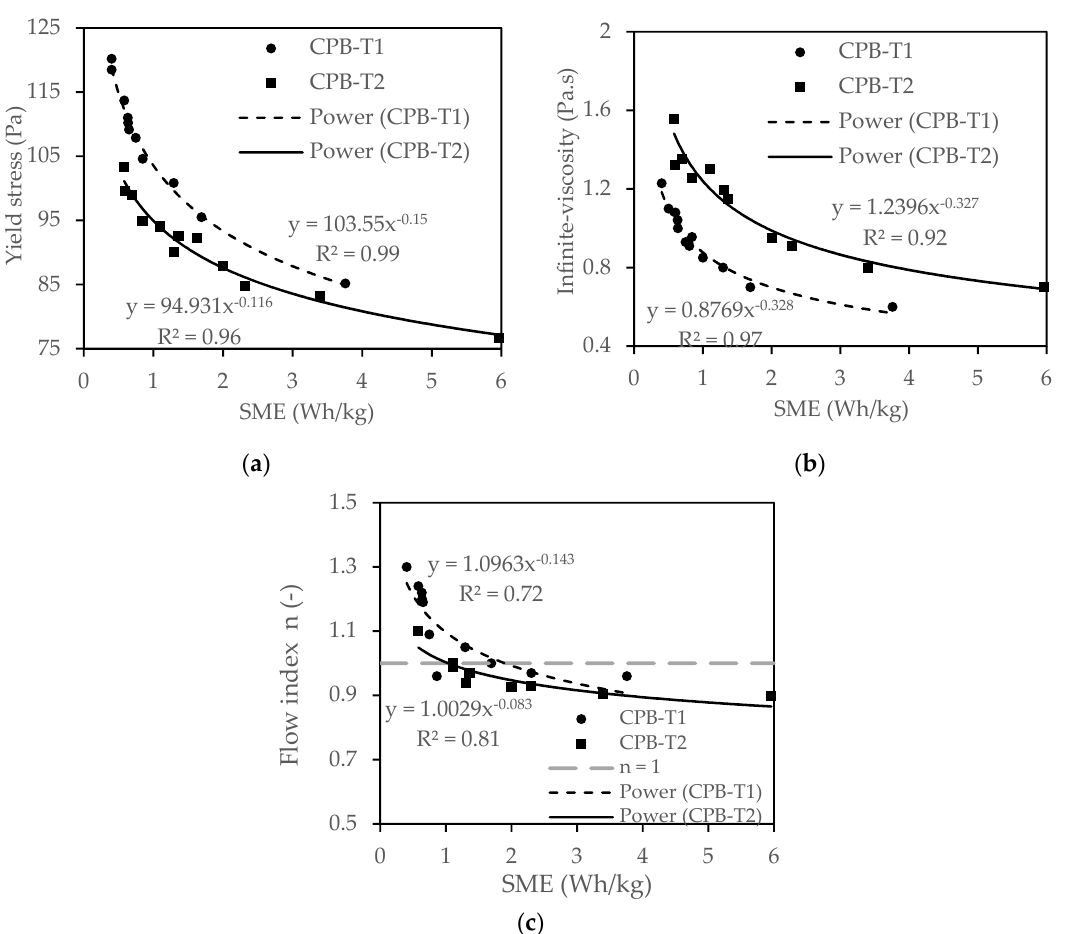
Figure 7. Effect of the SME on: ( a ) yield stress, ( b ) infinite viscosity and ( c ) flow index for CPB-T1 and CPB-T2.